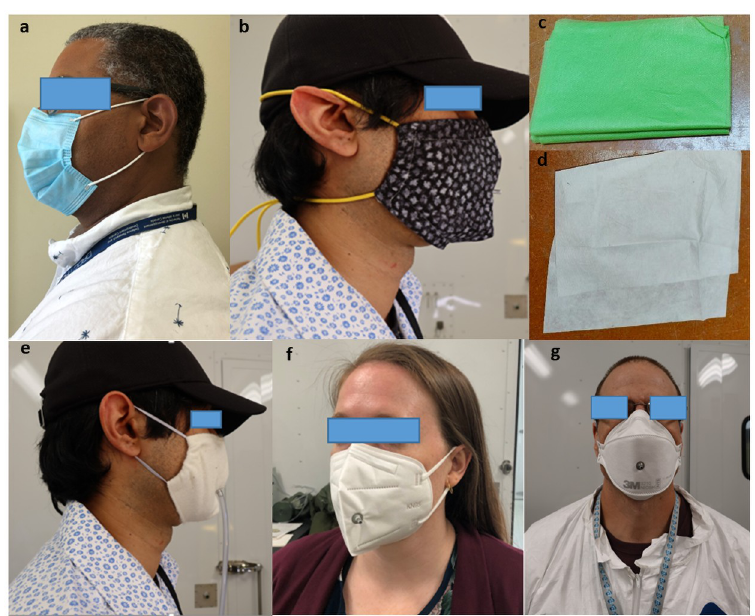
Fig 1. (a) Disposable procedure mask: Henan Liwei Biological Pharmaceutical Co. Ltd; (b) Multi-layer mask: four layered system comprised of two layers of quilt batting between an outer and inner layer of cotton; (c) Non-woven polypropylene ‘craft’ material (manufactured by smart-fab 1 ); (d) “N95-like” electret filter membrane material (purchased from Amazon.ca) used as the middle filter layer, as part of a multi-layer mask; (e) 2-Layer mask: quilt batting/cotton mask; (f) KN95 mask: MedSup Canada Protective Face Mask, and; (g) N95 FFR: 3M ™ model